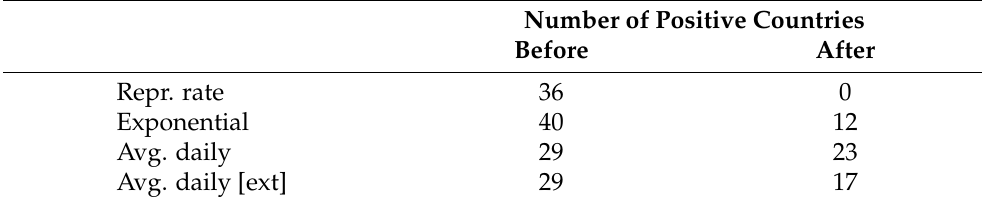
Table 3. The number of countries that are classified positive according to one of the infection classes. We compare the time interval before countermeasures (that we used) to a time interval of the same length starting with the countermeasures. In the [ext] row, the time interval was moved forward by another month.